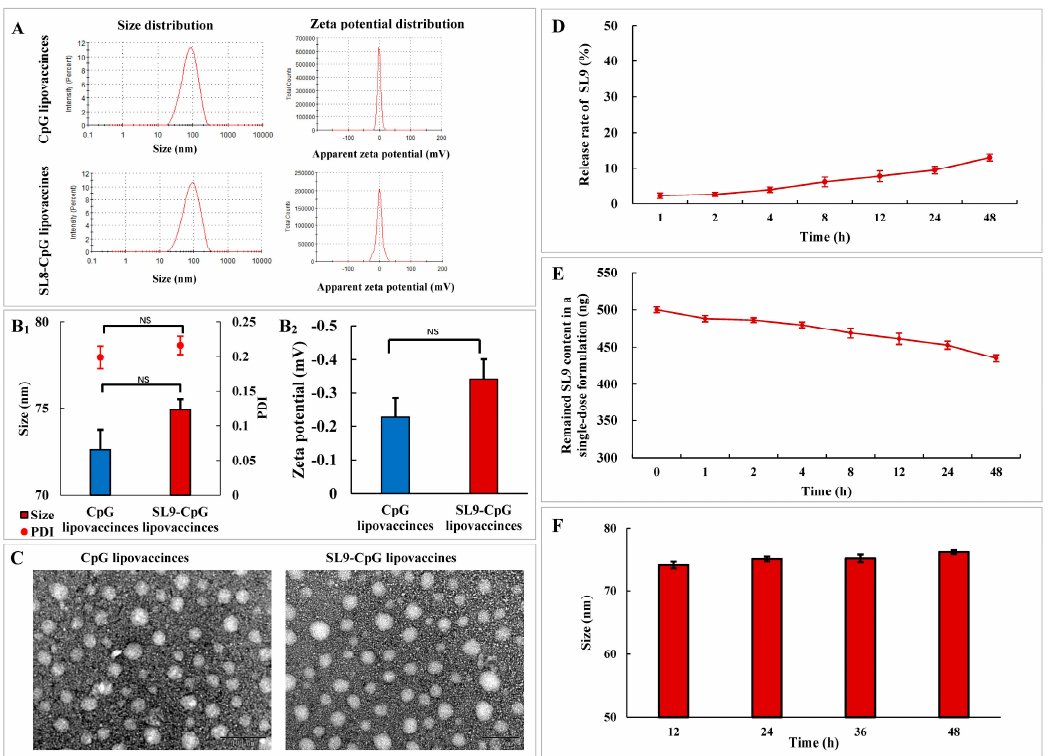
Figure 2. Characterization of SL9-CpG lipovaccines. Size and zeta potential distributions of CpG lipovaccines and SL9-CpG lipovaccines by dynamic laser scattering (DLS) ( A ). Size and PDI ( B1 ) and zeta potential ( B2 ) statistical results of CpG lipovaccines and SL9-CpG lipovaccines. PDI, polydispersity index. Data are presented as mean ± standard deviation ( n = 3). NS, not significant. Transmission electron microscope (TEM) images of CpG lipovaccines and SL9-CpG lipovaccines ( C ). Scale bar, 100 nm. Release rate of SL9-CpG lipovaccines in serum containing culture medium ( D ). Loading stability of a single-dose formulation of SL9-CpG lipovaccines in the phosphate buffered saline containing 10% fetal bovine serum (pH 7.4, 37 °C) ( E ). Particle stability of a single-dose formulation of SL9-CpG lipovaccines in phosphate buffered saline (pH 7.4, 37 °C) (F ). Data are presented as mean ± standard deviation ( n = 3).